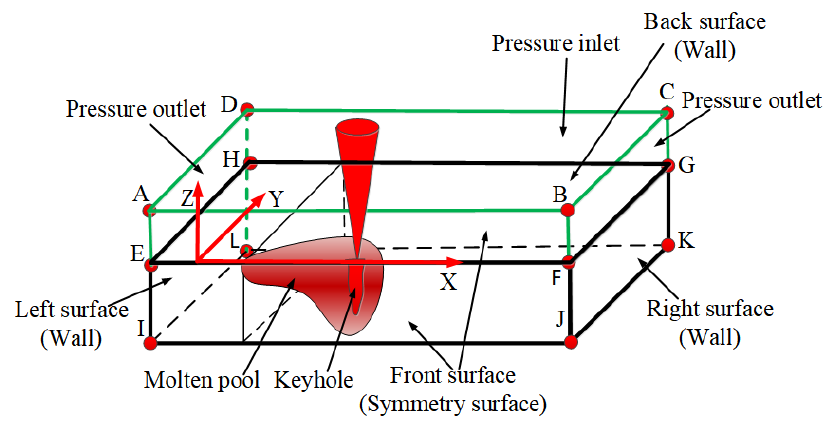
Figure 1. The calculation region of the laser welding.